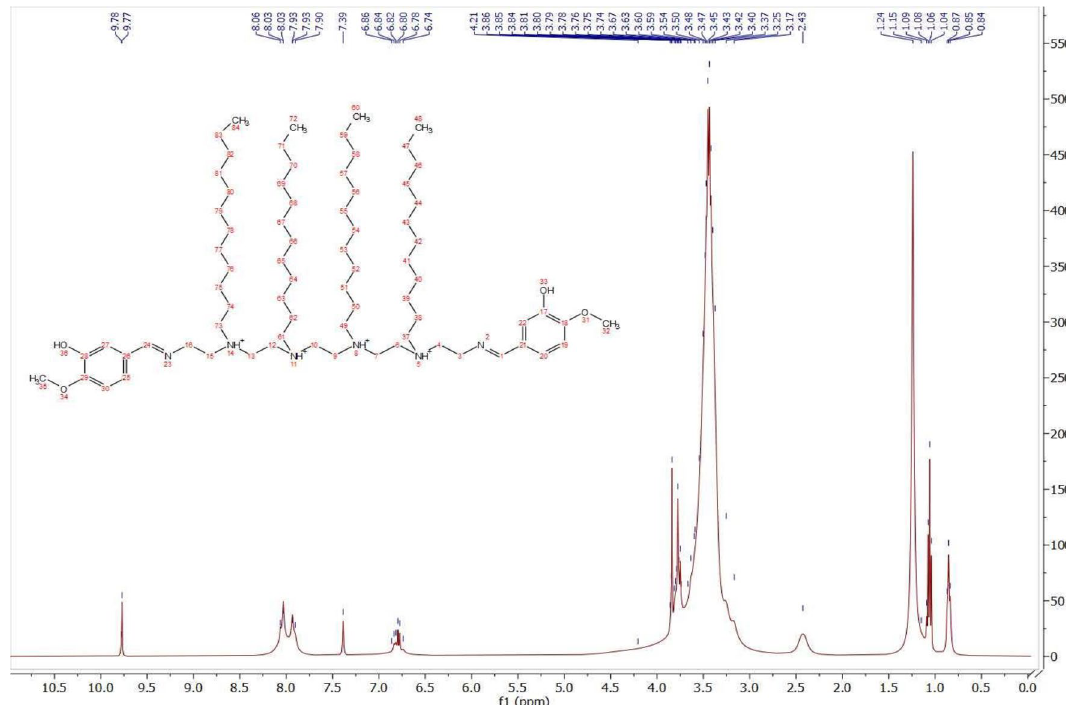
Figure 2. 1 HNMR spectrum of CS4